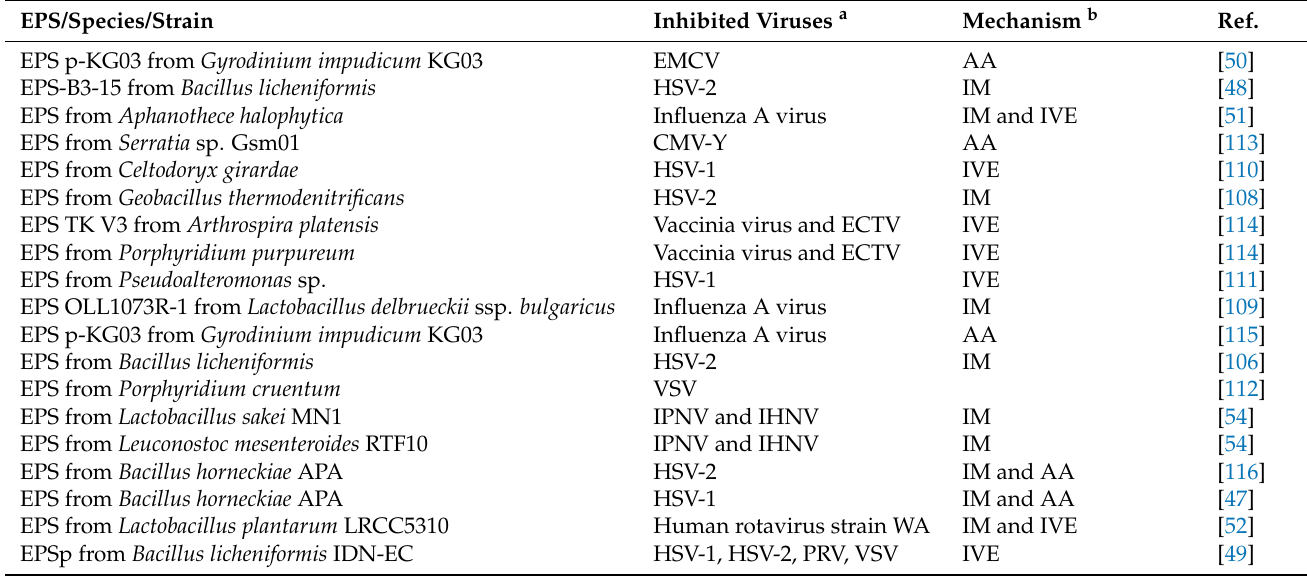
Table 1. EPS-producing microbial